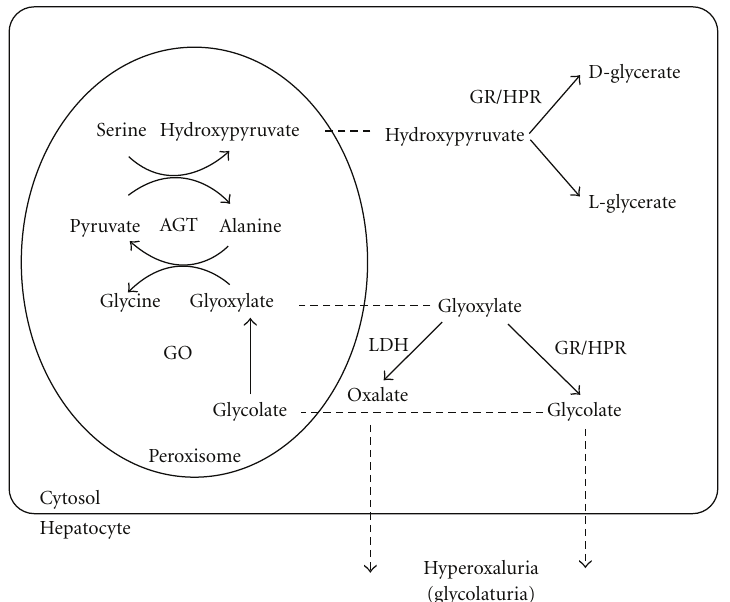
Figure 1: Reactions involved in oxalate, glyoxylate, and glycolate metabolism in human hepatocytes. Abbreviations: AGT alanine: glyoxylate aminotransferase; GR/HPR glyoxylate reductase/hydroxypyruvate reductase; GO glycolate oxydase; LDH lactate dehydrogenase.